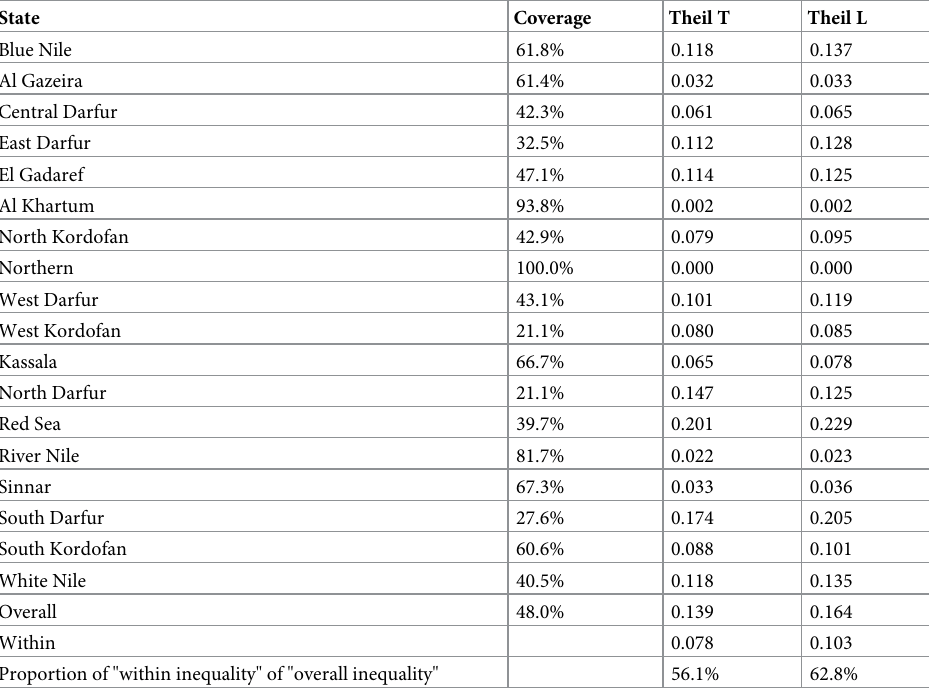
Table 4. Coverage of improved water at the school level.